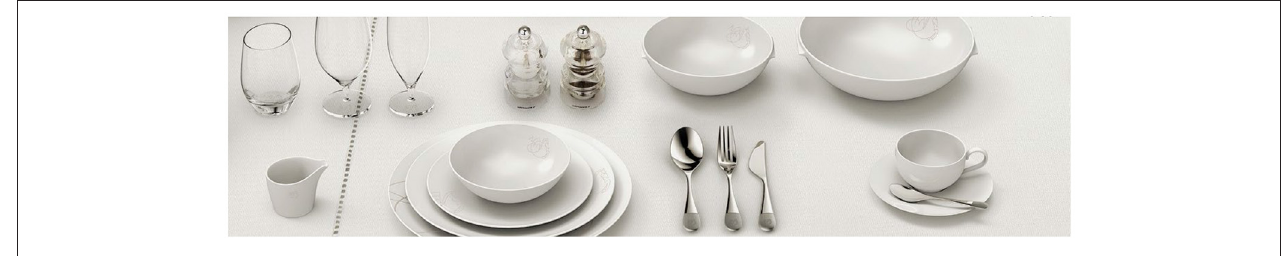
FIGURE 1 | Visual extract from webpage; airline#1 1